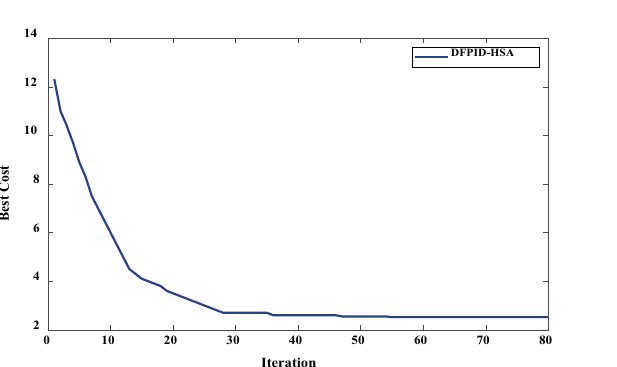
Figure 9. Solution convergence for DFPID-HAS.